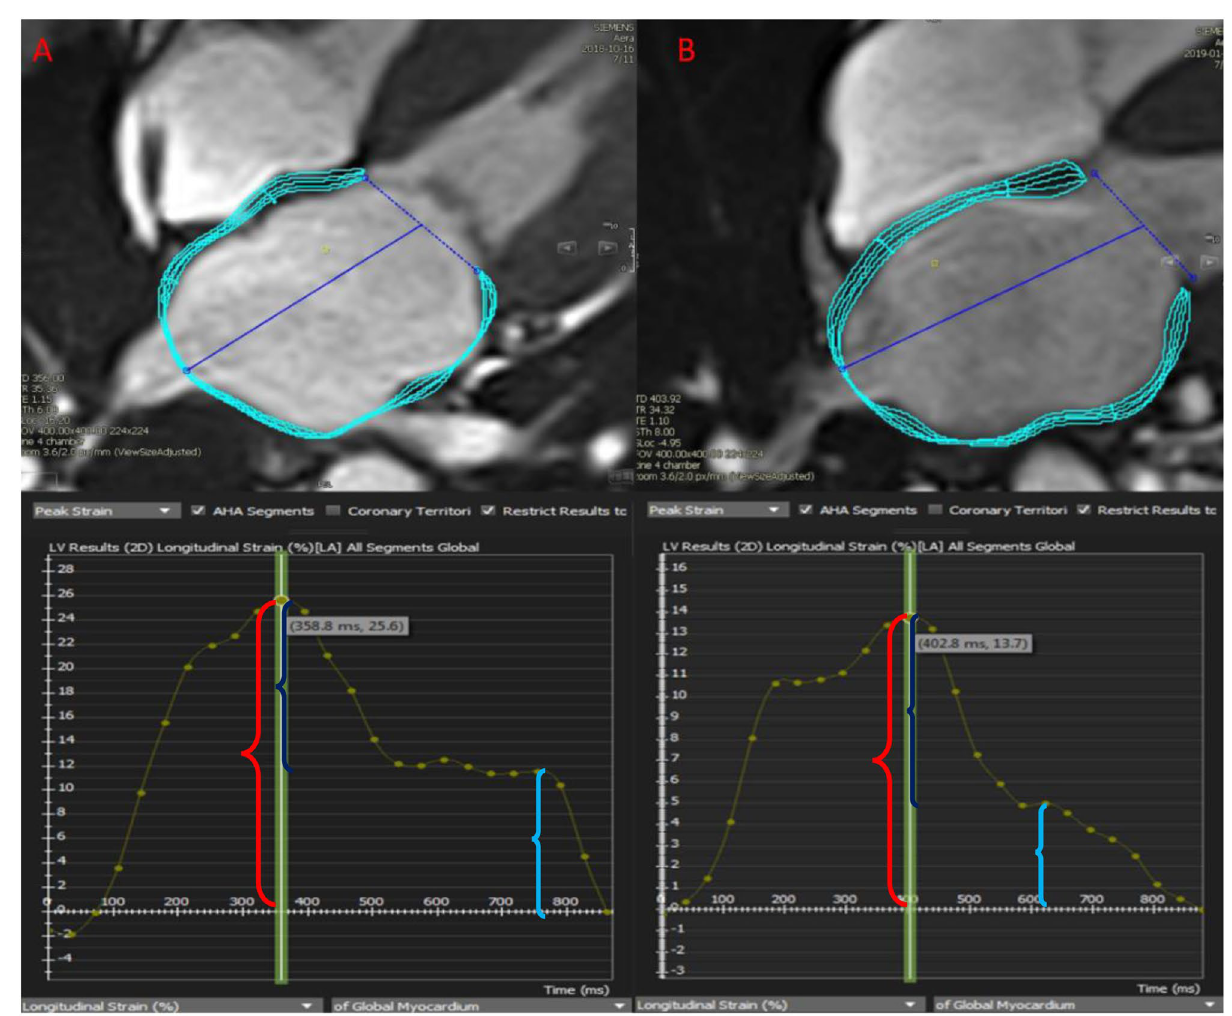
Figure 2. Global longitudinal left atrial (LA) strain curves ( A ) 60-year-old male diagnosed with AL amyloid with LV ejection fraction of 63%, LA reservoir strain = 26%, LA booster strain = 12%. ( B ) 65-year-old male diagnosed with ATTR amyloid with LV ejection fraction of 56%, LA reservoir strain = 14% LA booster strain = 4%. Red bracket parenthesis: Reservoir strain; light green bracket parenthesis: booster strain; blue bracket parenthesis: conduit